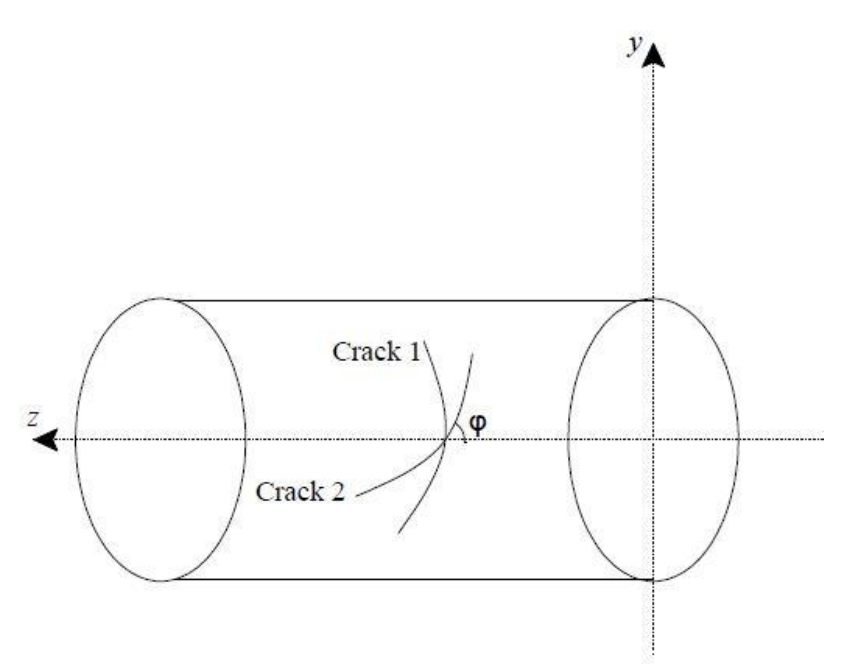
Figure 9. Geometric model of a thin-walled cylindrical shell with different cracks.